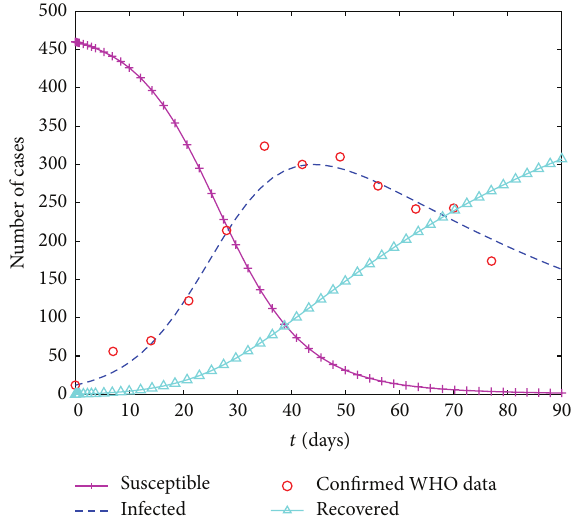
Figure 3: The evolution of susceptible ( 𝑆(𝑡) ), infected ( 𝐼(𝑡) ), and recovered ( 𝑅(𝑡) ) for the period July 14 ( 𝑡 = 0 ) and October 12, 2014 ( 𝑡 = 90 ), given by the Ebola Liberia model (4) with 𝛽 = 0.000318 , 𝜇 = 0.0175 , 𝑆(0) = 460 , 𝐼(0) = 12 , and 𝑅(0) = 0 . The real data of confirmed cases for the 2014 Ebola outbreak occurred in Liberia, taken from [18], is shown with circles.